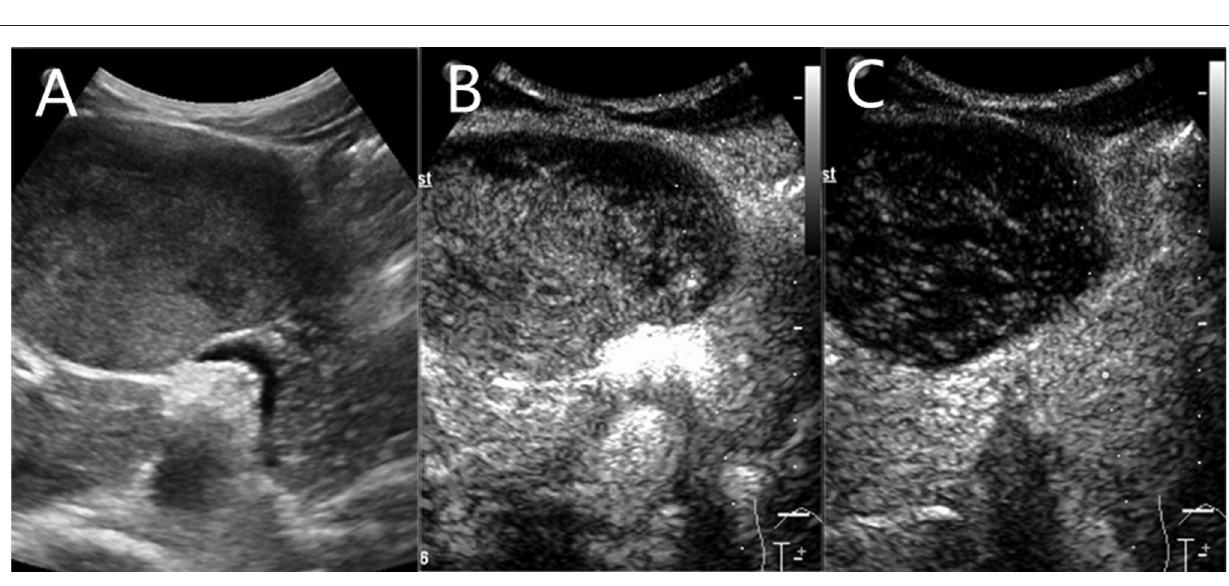
FIGURE 2 | A slightly weaker echogenic mass on ultrasound. ( A ) Two-dimensional ultrasonography. ( B ) contrast-enhanced ultrasound (CEUS) in arterial phase. ( C ) CEUS in parenchymal